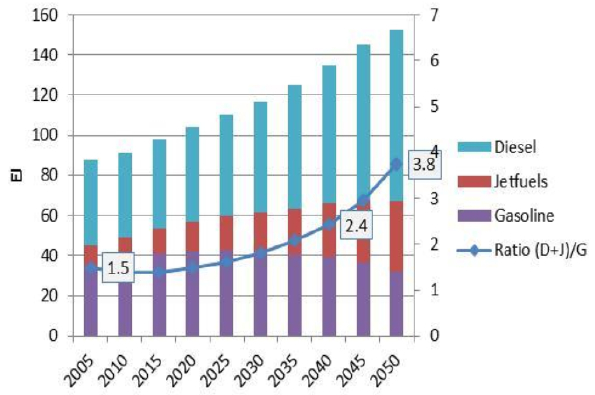
Fig. 3 Forecast of demand for different fuels [39].